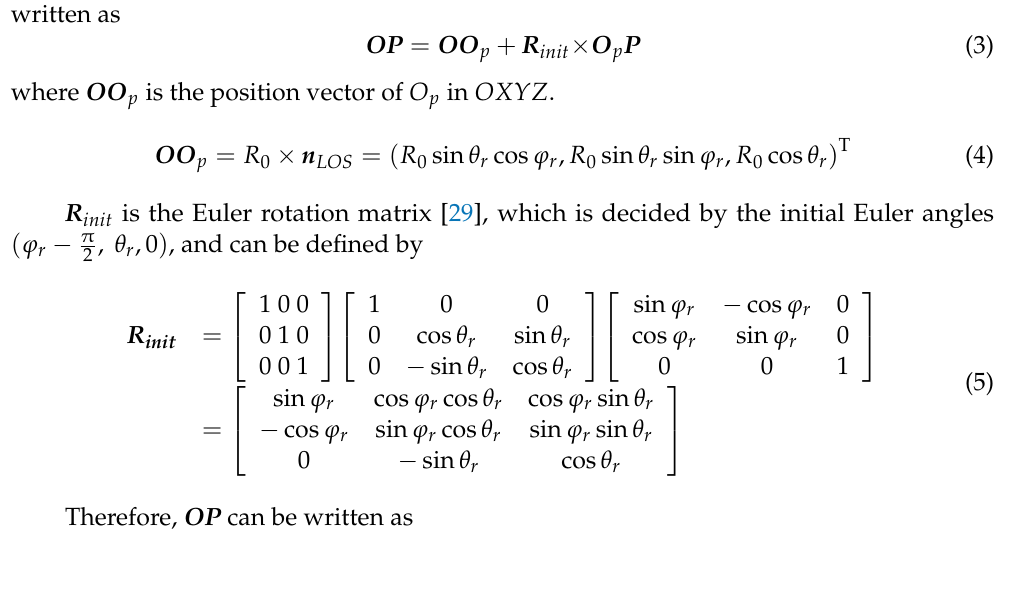
radar cannot effectively extract the micro-Doppler perpendicular to the radial